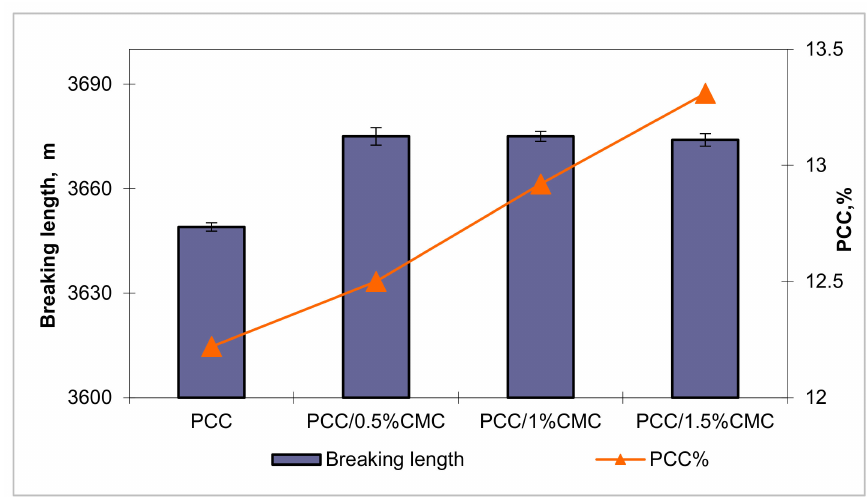
Figure 9. The effect of PCC modified with CMC of different levels on breaking length.